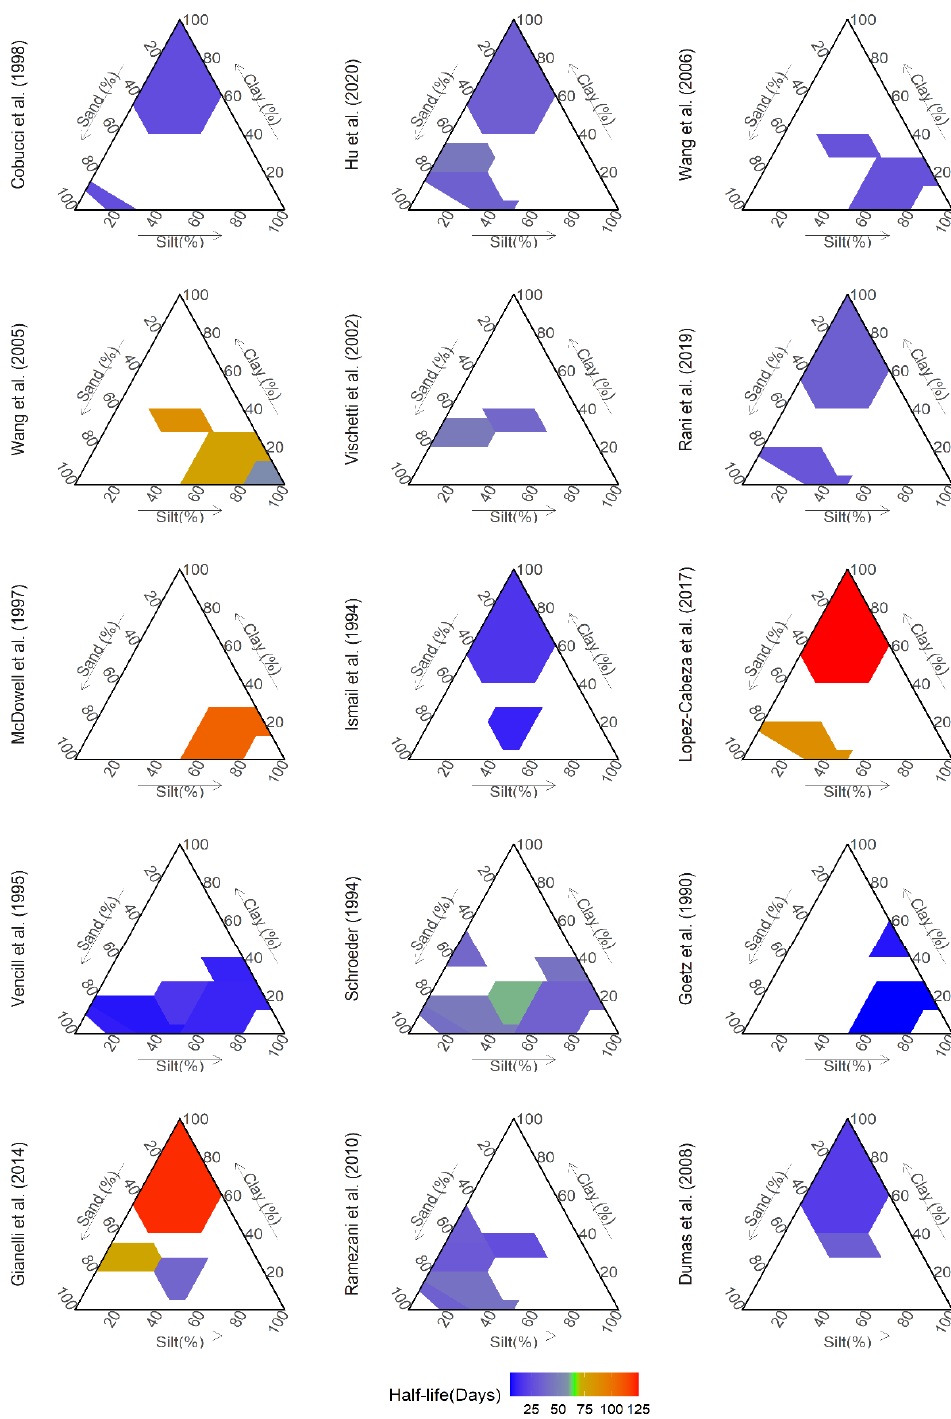
Figure 5. Half-life of imidazolinones as affected by soil texture (USDA Soil Texture Triangle, Source: Hamilton and Ferry [41]).